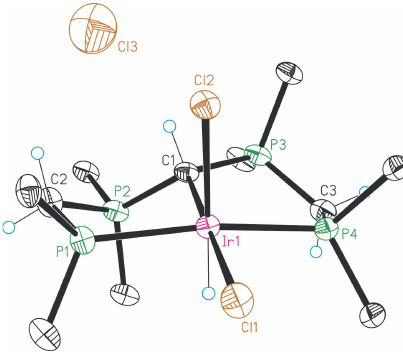
Figure 4 Structure of compound 4 , with atom labelling and 30% probability displacement ellipsoids. For clarity, only the ipso carbon atoms of the phenyl groups are shown, and the solvent molecules have been omitted.